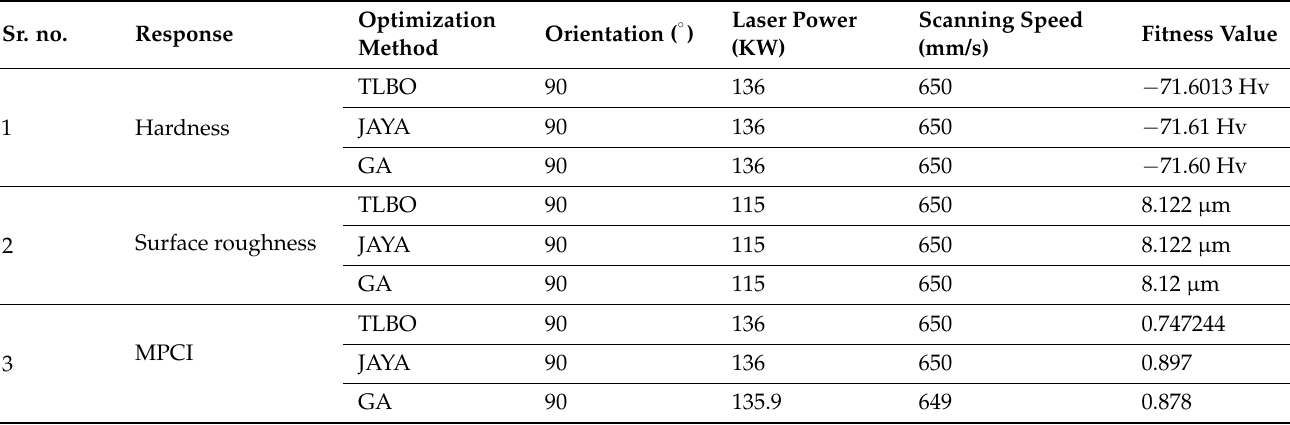
Figure 12. Comparative Convergence plot for the MPCI by TLBO JAYA and Genetic Algorithm. Table 6. Optimum results given by TLBO, JAYA, and